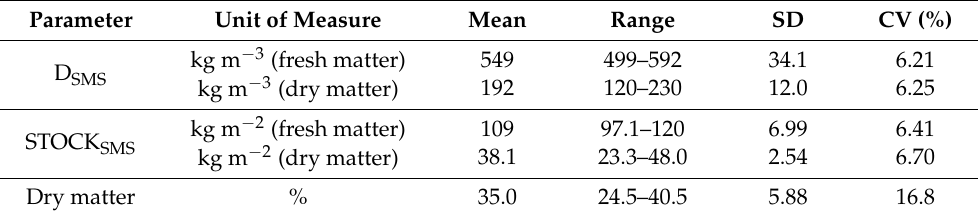
Table 2. Physical properties of the tested spent mushroom substrates (SMSs).